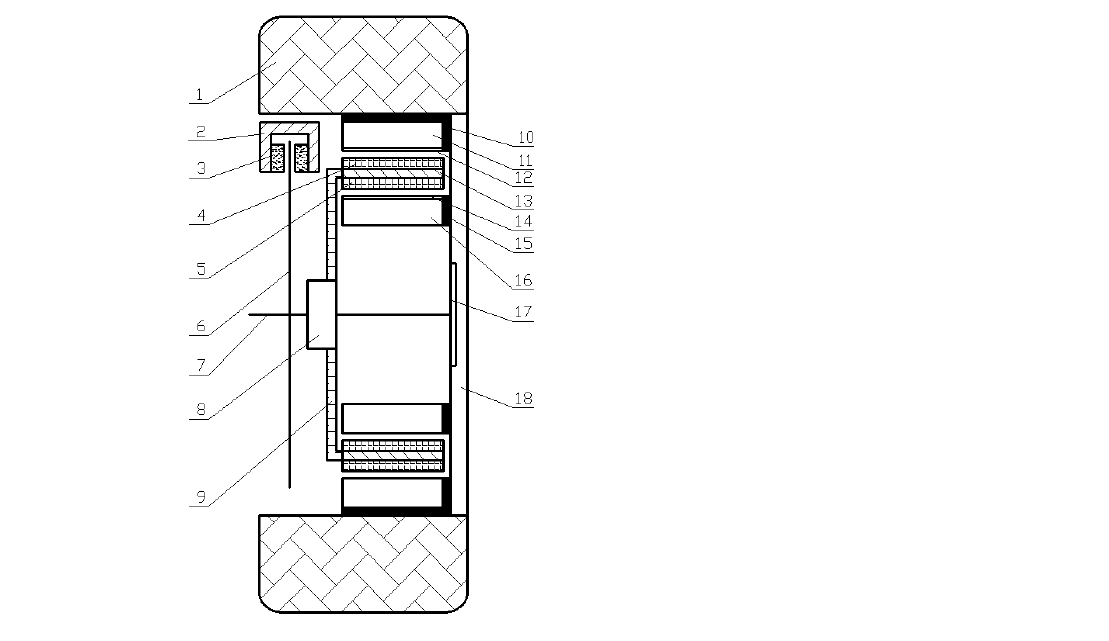
Figure 1. Double rotor permanent magnet braking device. 1 — wheel; 2 — brake caliper body; 3 — friction block; 4 — outer permanent magnets; 5 — inner permanent magnets; 6 — brake disc; 7 — half shaft; 8 — electromagnetic clutch; 9 — connecting part; 10 — thermal insulation element; 11 — outer rotor drum; 12 — outer copper coating; 13 — bracket; 14 — inner copper coating; 15 — thermal insula- tion element; 16 — inner rotor drum; 17 — half shaft flange; 18 — hub.